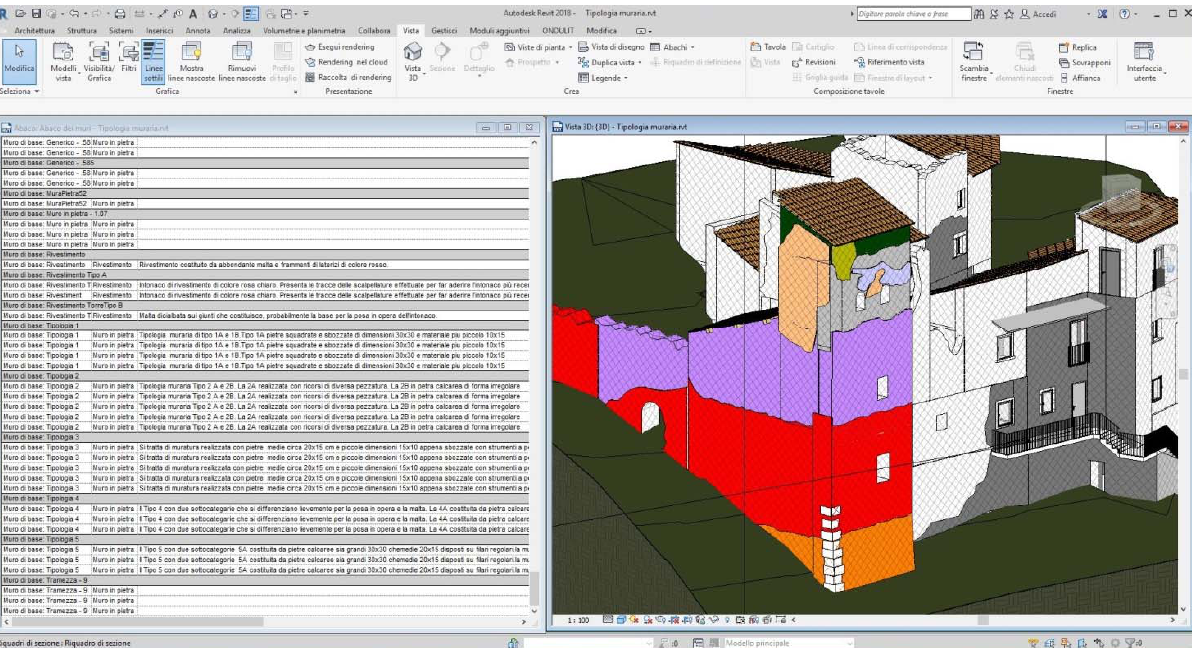
Figure 5: Screenshot of the Revit software with the archaeological analysis of the